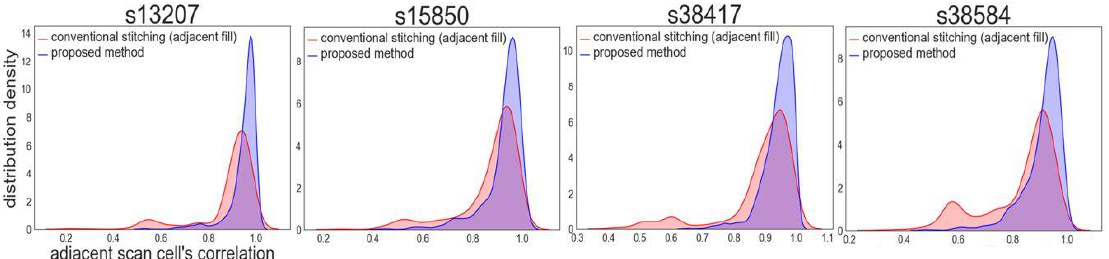
Figure 11. Comparison of the correlation distributions of the adjacent scan cells.